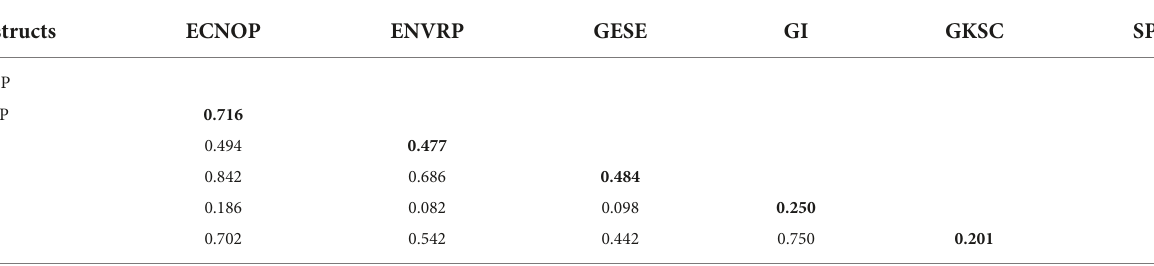
TABLE 4 Heterotrait-Monotrait ratio